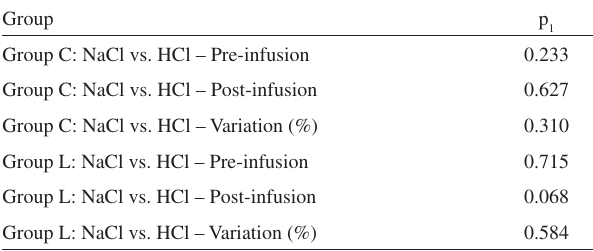
Table 2 - Comparison among the various combinations of groups (patient groups C and L observed via an upper gas- trointestinal endoscopy and receiving infusion of either HCl or NaCl) in terms of electron microscopy results (i.e., the morphometric analysis)